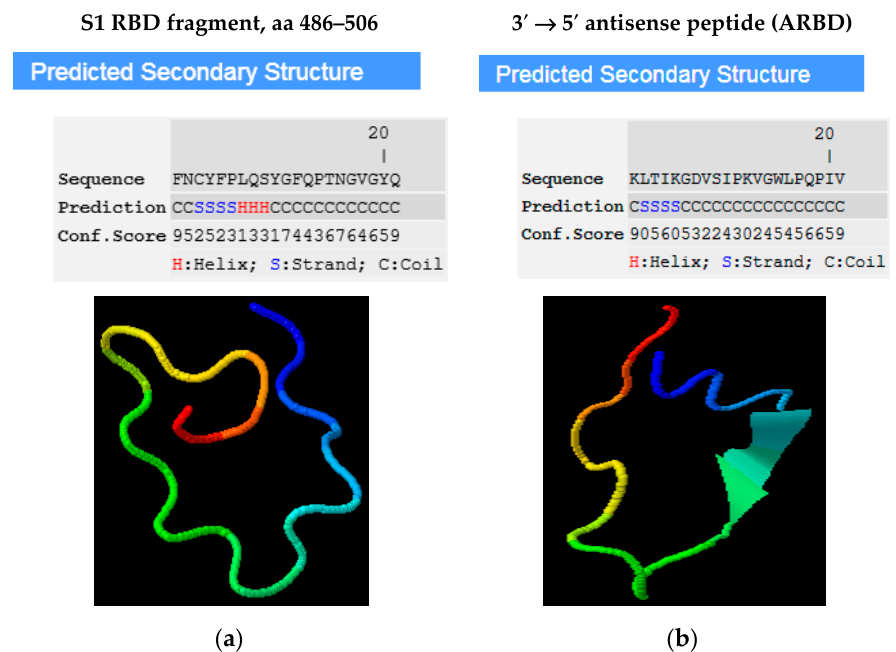
Figure A1. ( a ) Receptor binding domain fragment aa 486–506 of S1 SARS-CoV-2 protein (PDB file: Table S5), and its antisense peptide translated in 3 ′ → 5 ′ direction (PDB file: Table S6) ( b ). Peptide structure prediction and modeling was done using I-TASSER (Iterative Threading ASSEmbly Refinement) [80].